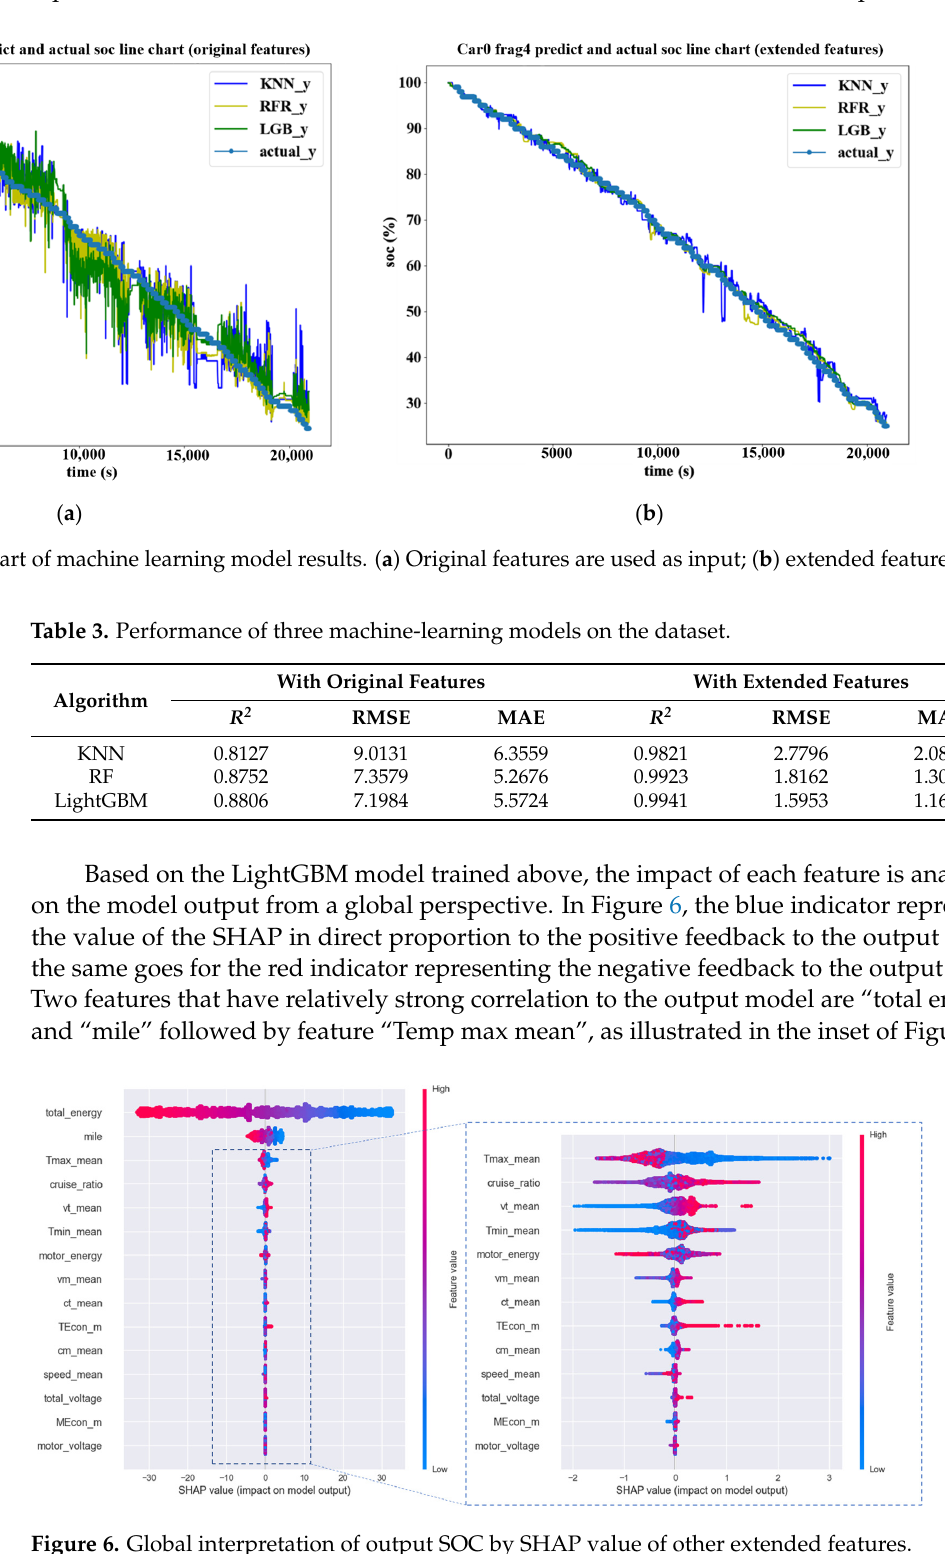
Figure 6. Global interpretation of output SOC by SHAP value of other extended